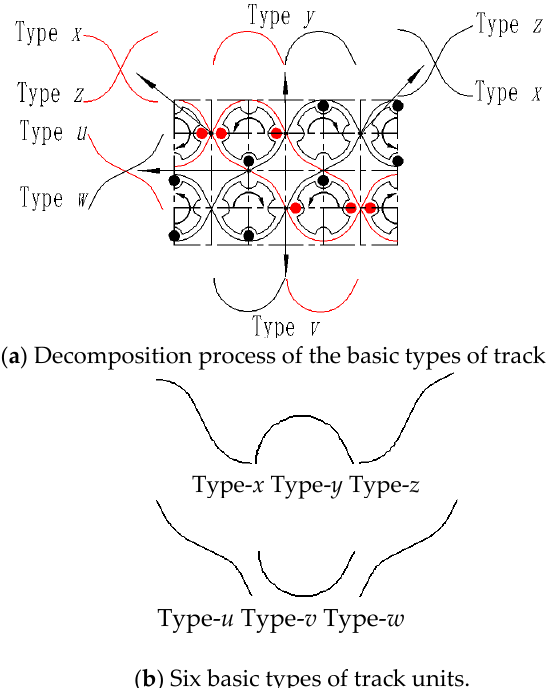
( a ) Decomposition process of the basic types of track units